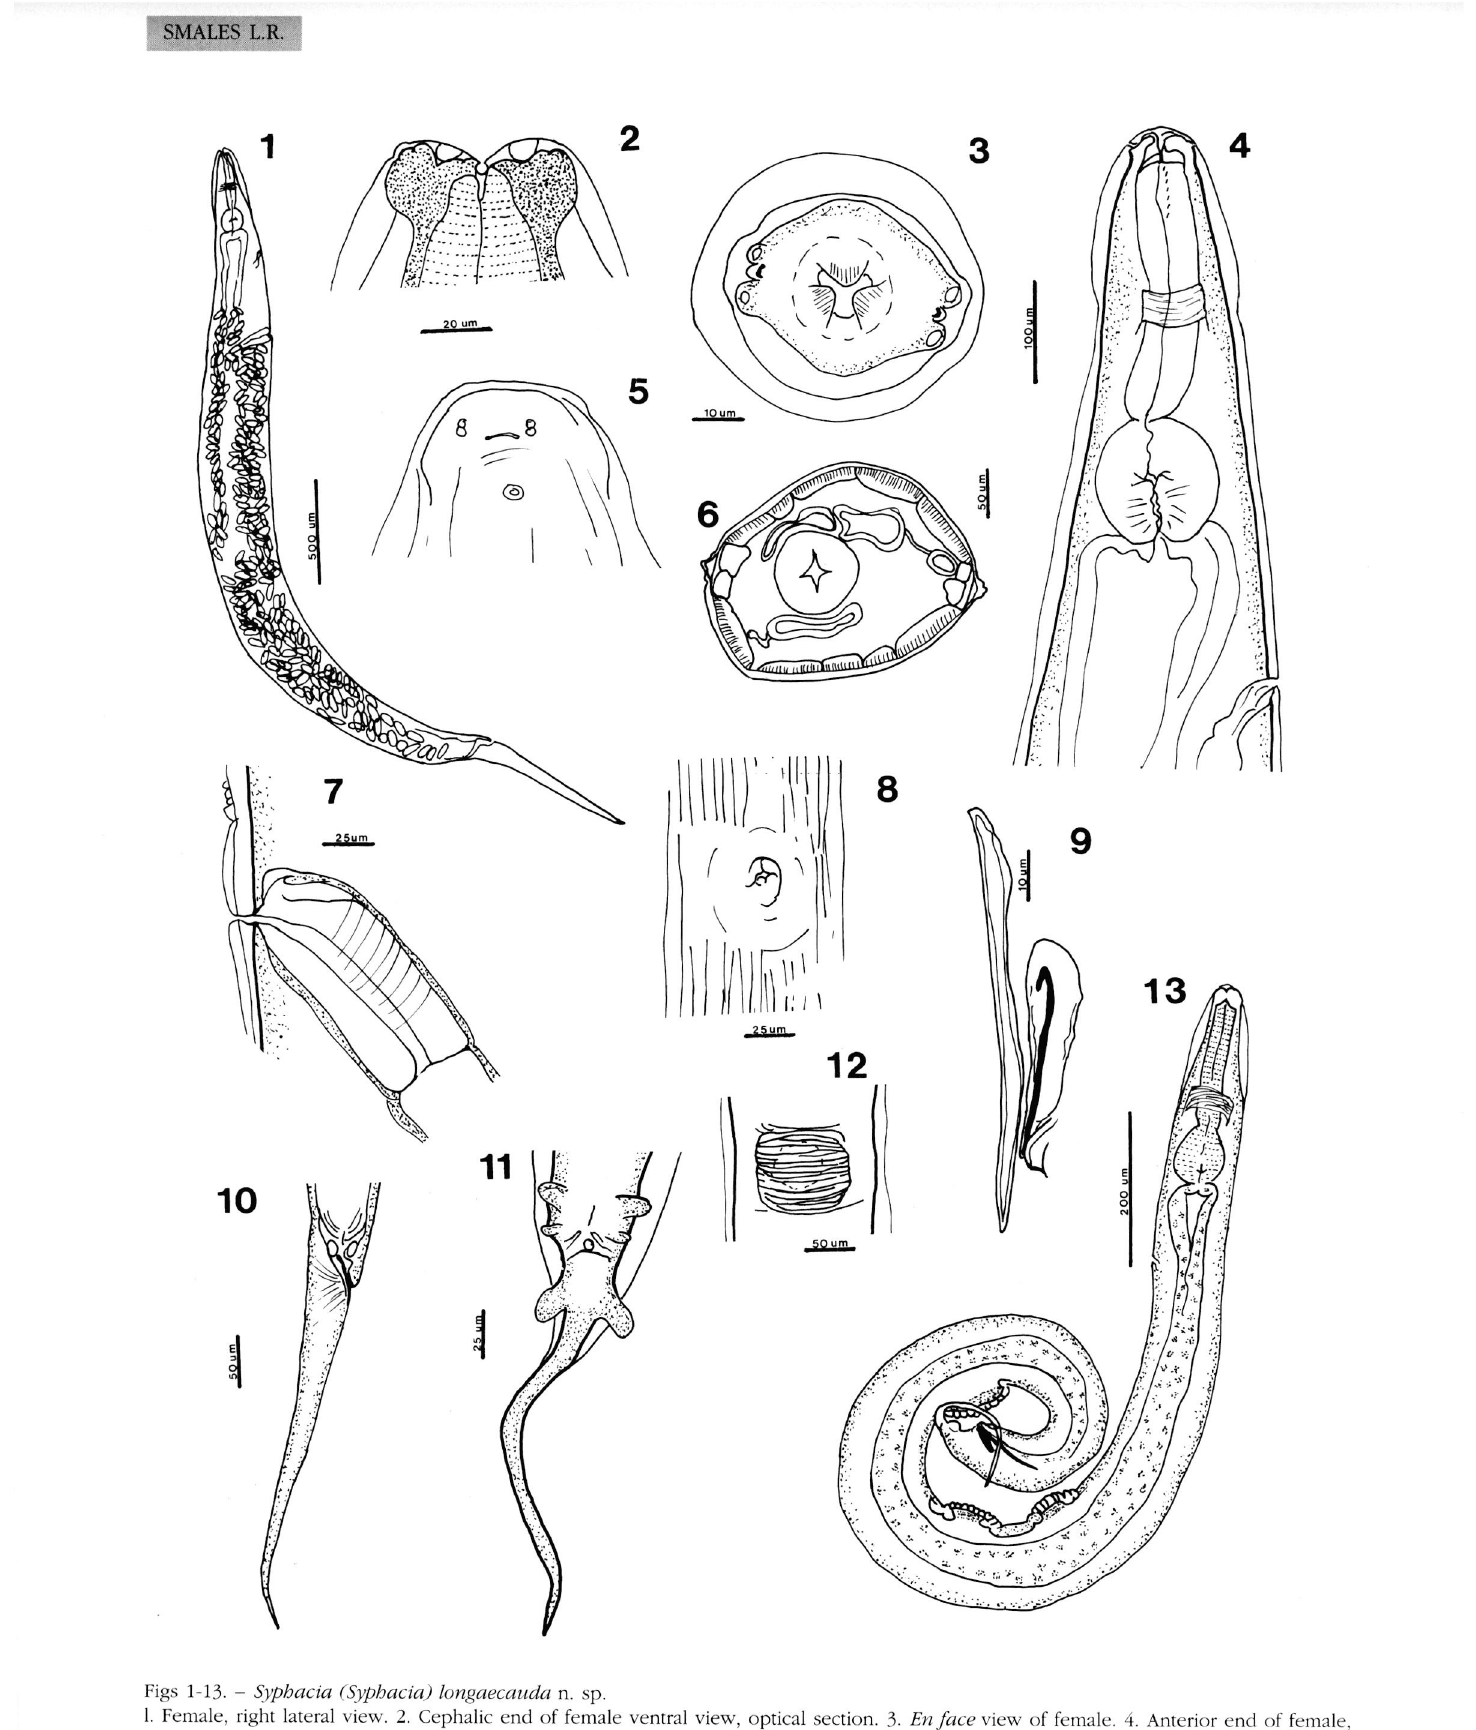
Figs 1-13. - Syphacia (Syphacia) longaecauda n. sp. 1. Female, right lateral view. 2. Cephalic end of female ventral view, optical section. 3. En face view of female. 4. Anterior end of female, right lateral view. 5. Cephalic end of male, left lateral view. 6. Hand cut transverse section of female, at level of oesophagus. 7. Vagina, left lateral view. 8. Vulva, ventral view. 9. Spicule and gubernaculum. 10. Female tail, left lateral view. 11. Male tail, ventral view. 12. Mamelon, ventral view. 13. Male, left lateral